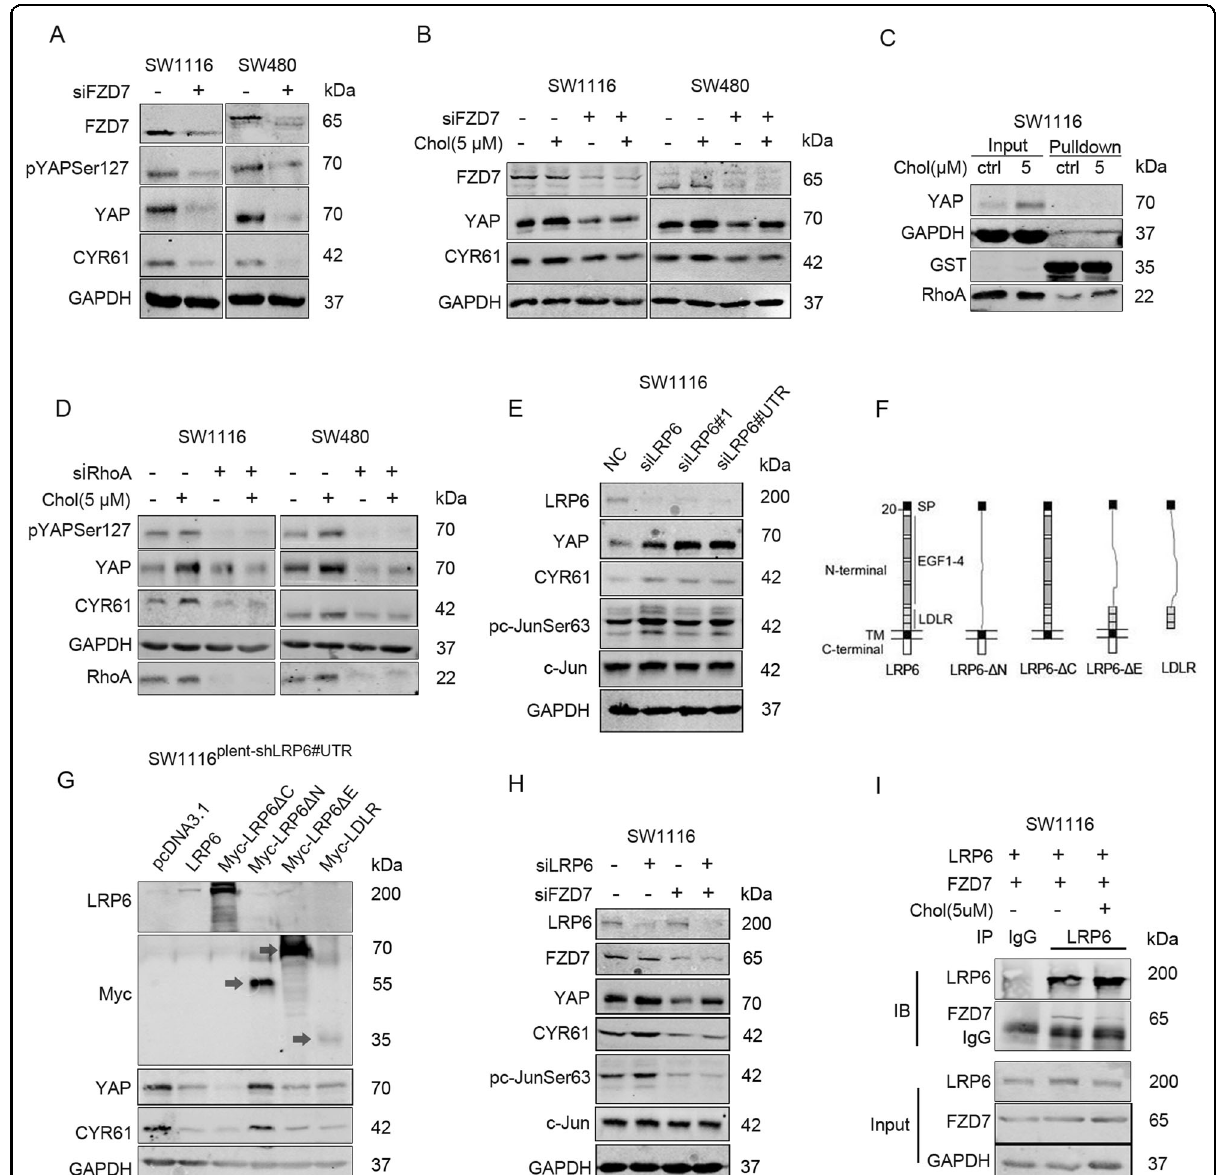
Fig. 4 Cholesterol alleviates the inhibitory effect of LRP6 on FZD7-PCP pathway to promote YAP expression in colon cancer cells. A SW1116 and SW480 were transfected with negative control siRNA or FZD7 siRNA for 72 h, respectively. B SW1116 and SW480 were transfected with negative control siRNA or FZD7 siRNA for 48 h, and starved in serum-free medium for 24 h, then incubated with DMSO or cholesterol (5 μ M) for 2 h, respectively. C SW1116 cells were starved for 24 h, then incubated with DMSO or cholesterol (5 μ M) for 2 h. RhoA activity was detected by GST pull- down assay. D SW1116 and SW480 were transfected with negative control siRNA or RhoA siRNA for 48 h, then starved for 24 h, and incubated with DMSO or cholesterol (5 μ M) for 2 h, respectively. E SW1116 were transfected with siLRP6, siLRP6#1, and siLRP6#UTR (targeting 5 ’ -untranslated region of LRP6 mRNA) for 72 h. F Schematic diagram of LRP6 and LRP6 deletion mutants. G SW1116 stably expressing shLRP6#UTR was constructed by lentiviral vector. SW1116 stable cell line were transfected with control vector or LRP6 and deletion mutants vectors for 72 h. H SW1116 was transfected with negative control siRNA or siLRP6, in the presence or absence of FZD7 deletion. I SW1116 was transfected with vectors expressing LRP6 and FZD7 for 48 h, followed by starvation for 24 h, and then treated with cholesterol (5 μ M) or DMSO for 2 h. Co-IP assay was performed to detect the interaction between LRP6 and